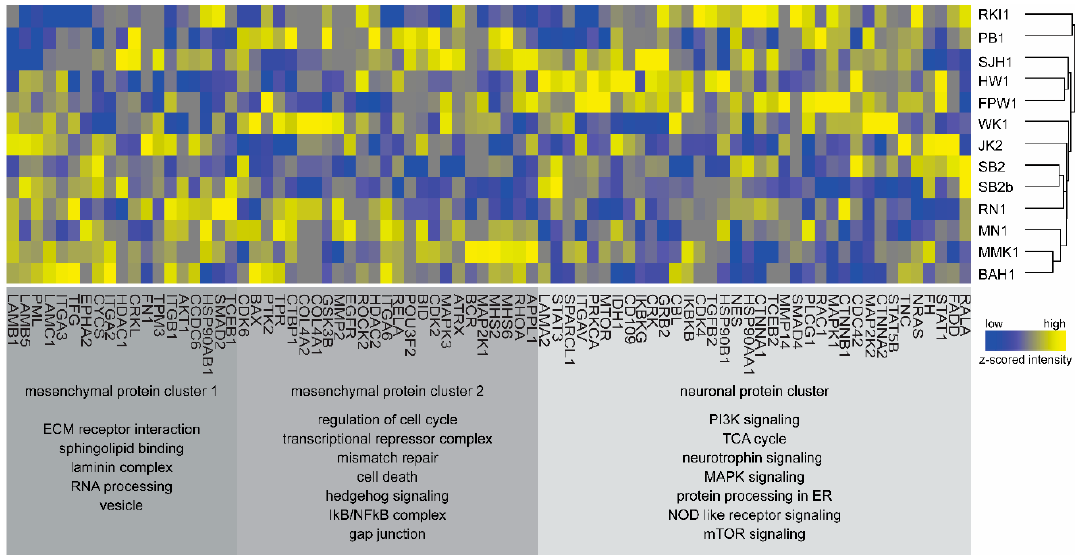
Figure 5. Functional analysis of the expressed proteome. Heatmap of proteins (z-scored intensities) belonging to the KEGG cancer pathway. The proteins segregate into three clusters: mesenchymal cluster 1, mesenchymal cluster 2, and neuronal cluster listing the pathways that proteins represent. Dendrogram depicts the similarity in protein profiles among the 13 cell lines. Colour legend: blue, low expression; and yellow, high expression.